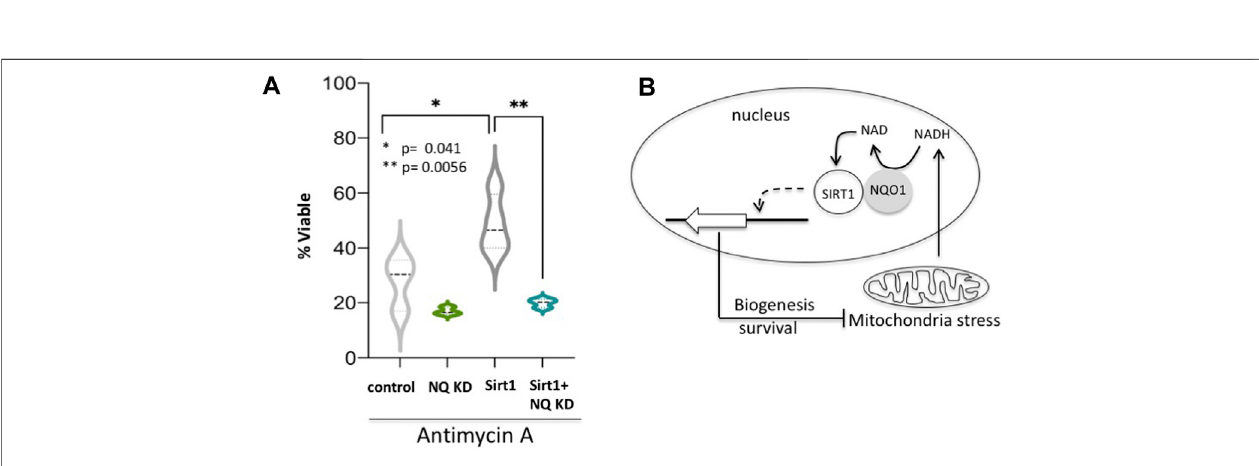
FIGURE 6 | NQO1-SIRT1 circuit determines cell fate. (A) C2C12 cells either over expressing SIRT1 or the shRNA for NQO1 (NQ KD) or both were treated with Antimycin A and the viability was examined after 48 h. (B) The NADH metabolism in regulating the SIRT1-NQO1-PGC-1 α feedback loop and mitochondrial biogenesis are schematically